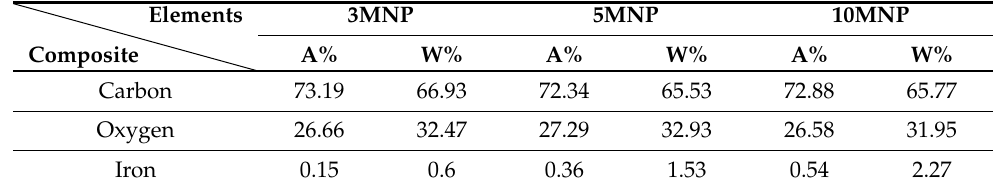
Figure 6. EDX-mapping analysis of nanoparticles incorporated scaffolds, ( a ): carbon, ( b ): oxygen, and ( c ): iron. Table 1. Elemental content of the magnetite enriched PCL scaffolds resulted from EDX analysis.